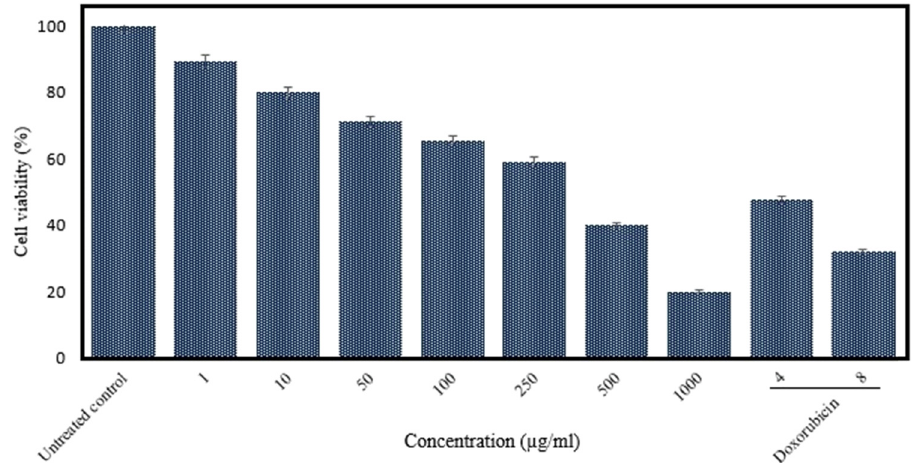
Figure 5: Cell viability of CFN on neuronal cell line in comparison with doxorubicin as positive control and untreated control ( * P value < 0.01 )